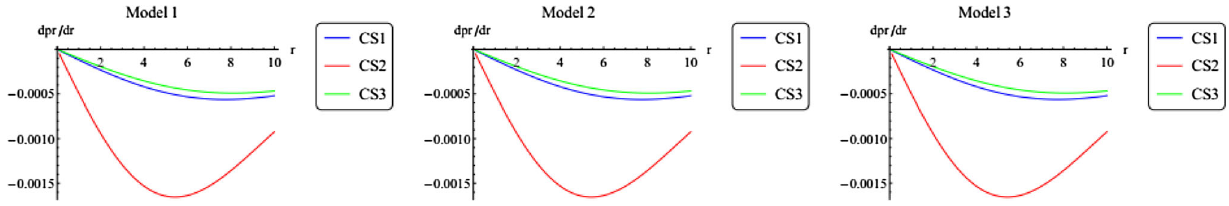
Fig. 5 Evolution of dp r / dr for charged stars, Vela X-1, SAX J 1808.4-3658, and 4U 1820-30, under different viable f ( G )